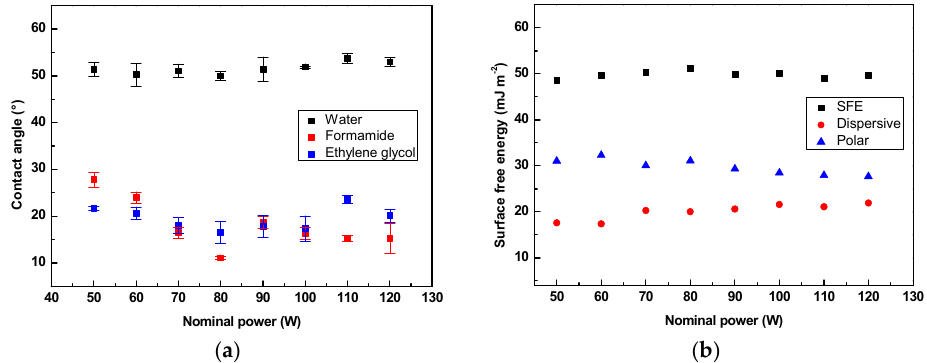
Figure 2. Surface wettability of low-density polyethylene (LDPE) as a function of nominal power for LDPE modified using air plasma for 60 s: ( a ) contact angle; ( b ) surface free energy (SFE).